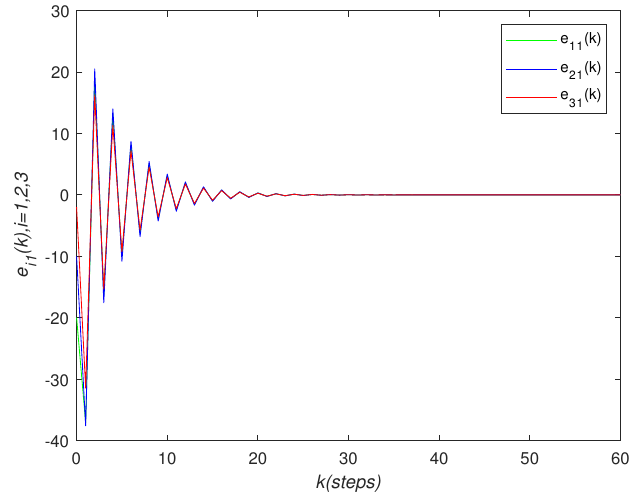
Figure 8. Estimated error trajectory e i 1 ( k ) .